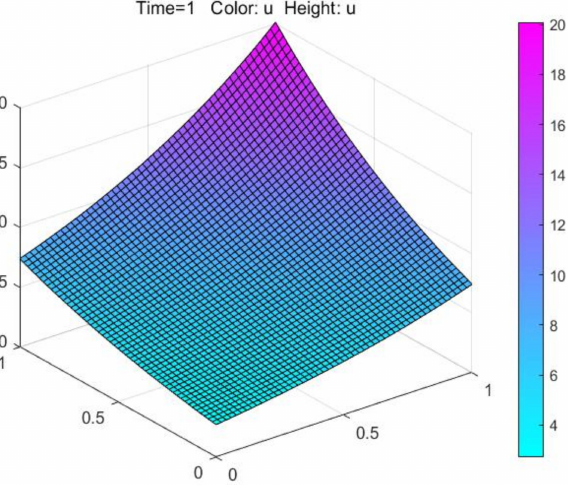
Figure 3. Numerical solutions obtained by PDETOOL of